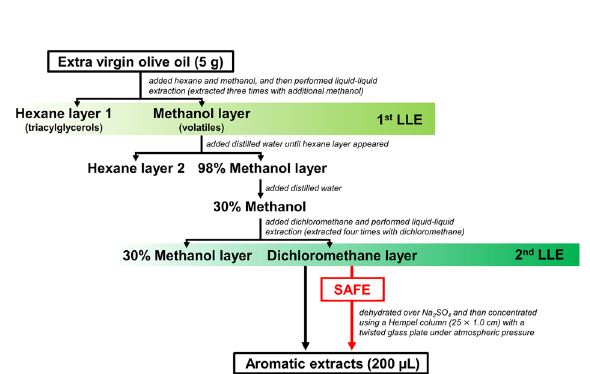
Fig. 1 Procedures of OA-LLE with/without SAFE for EVOO. The procedures for OA-LLE and OA-LLE + SAFE are indicated by black arrows and a red arrow, respectively. The “ Dichloromethane layer ” contains most of the volatile compounds in EVOO. SAFE removed the non-volatiles such as pigments from the “ Dichloromethane layer ”